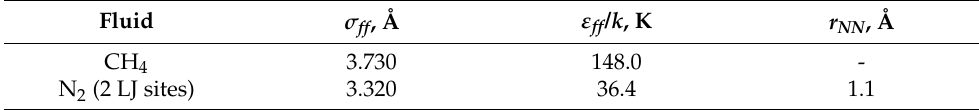
Table 1. Molecular parameters for methane and nitrogen (r NN is the separation distance between two N atoms).